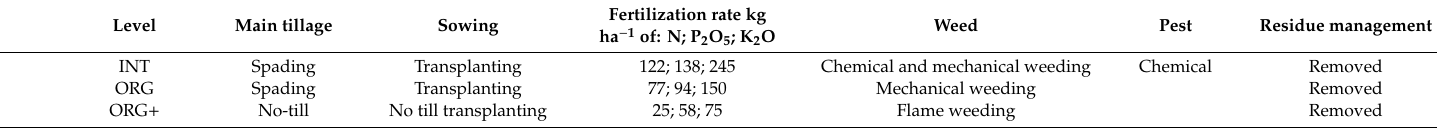
Table 2. Agricultural practices carried out in field 1 for each crop in the three cropping systems; in field 2 the same agricultural practices were carried out, starting with savoy